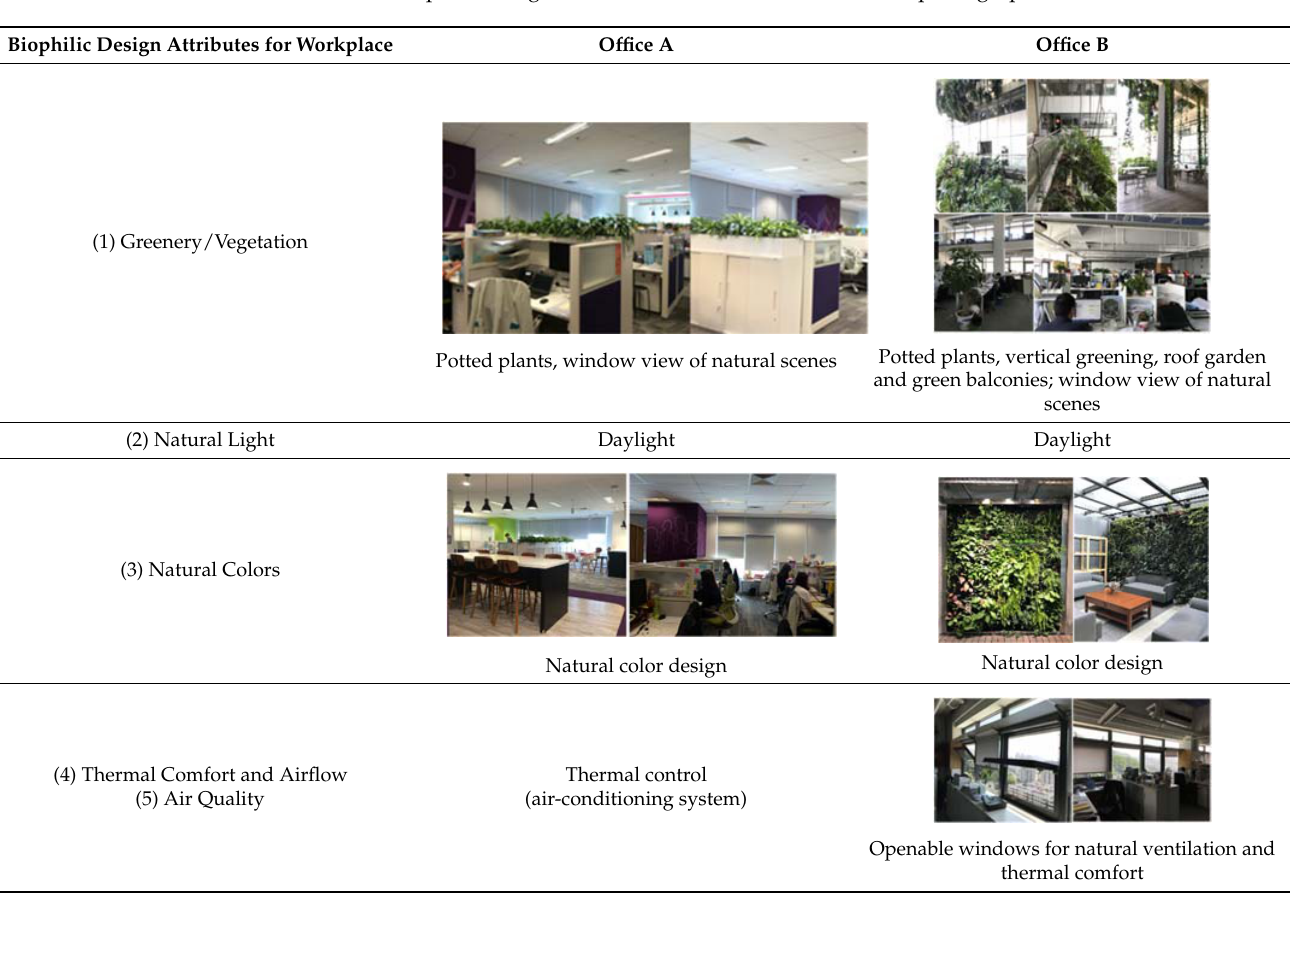
Table 6. Biophilic design attributes in the selected offices and photographic records.